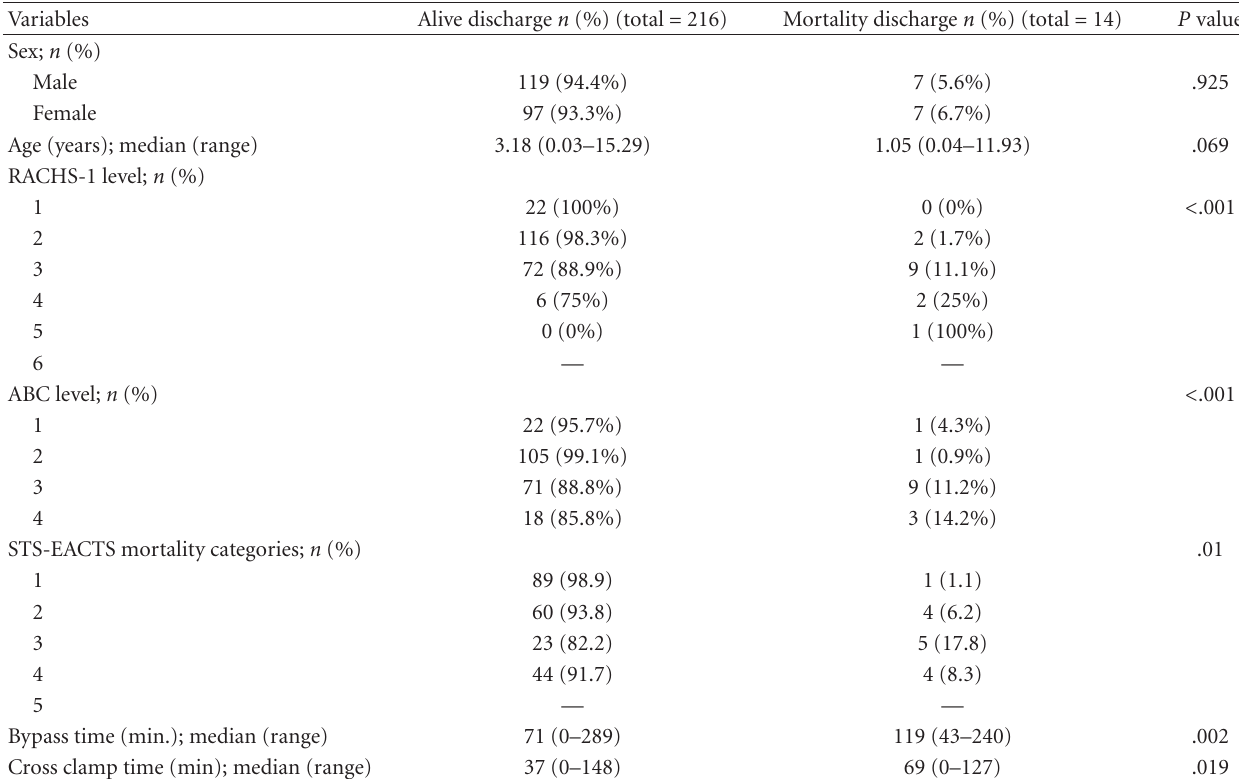
Table 5: Univariate analysis of independent variables in the present study ( n = 230).